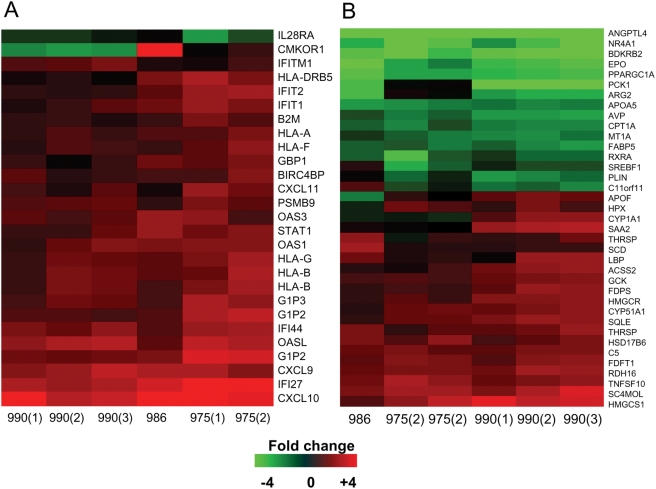
Expression of IFN-inducible and lipid metabolism genes in human liver tissue from HCV-infected mice.The gene sets were IFN-inducible (A), or involved in lipid metabolism (B). Two-dimensional hierarchical clustering was performed using Resolver System software with an agglomerative algorithm, complete link heuristic criteria, and Euclidean correlation metric. Each column represents gene expression data from an individual experiment (either individual HCV-infected mouse or individual liver sample). Genes were selected as at least 2-fold regulated (P value<0.05) in at least 1 experiment. Genes shown in red are up-regulated and genes shown in green are down-regulated in HCV-infected tissue relative to donor-matched uninfected tissue, while black indicates no change in gene expression. Animal 990 was infected with H77c (+) serum. Animal 975 H77c RNA by intrahepatic injection while animal 986 received H77c RNA containing the GDD-AAA mutation in the NS5B coding region.